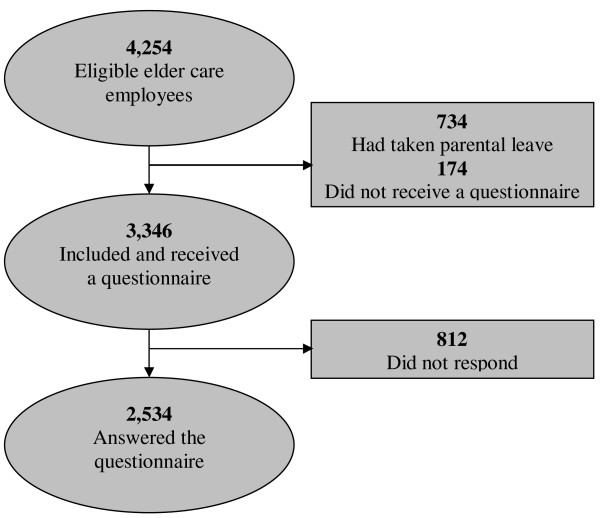
Flowchart of the selection of eldercare employees into the study.